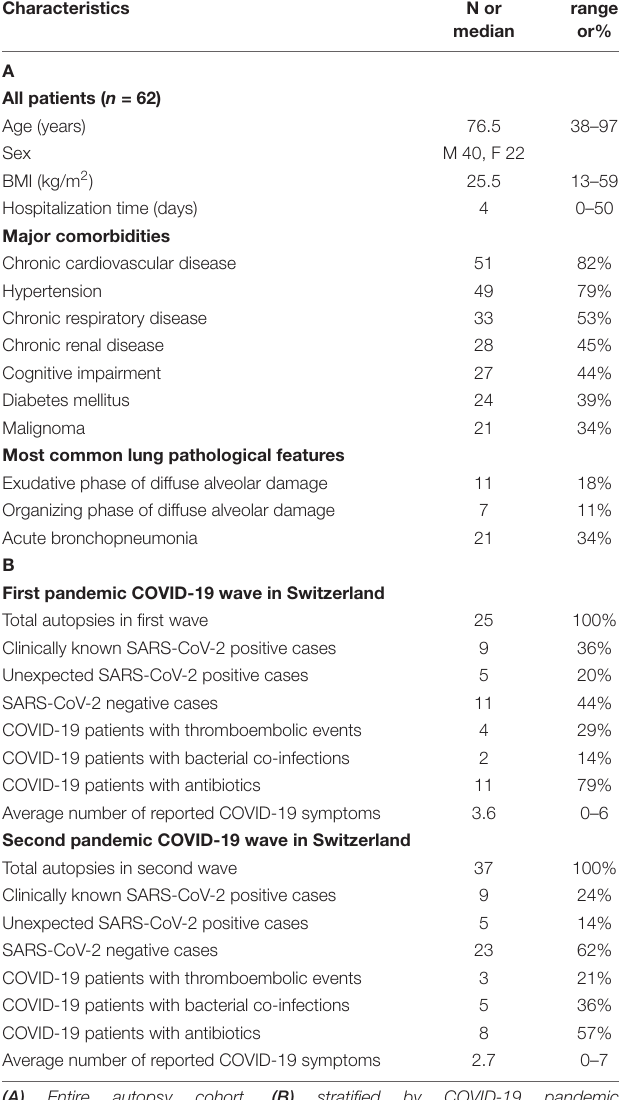
TABLE 1 | Clinicopathological details of